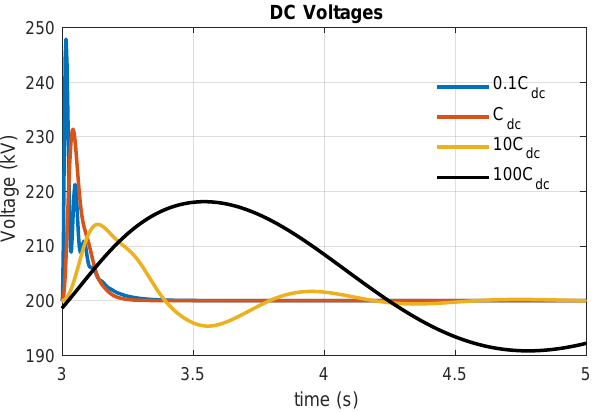
Figure 25. Time domain plot of grid side DC voltage varying DC capacitance.